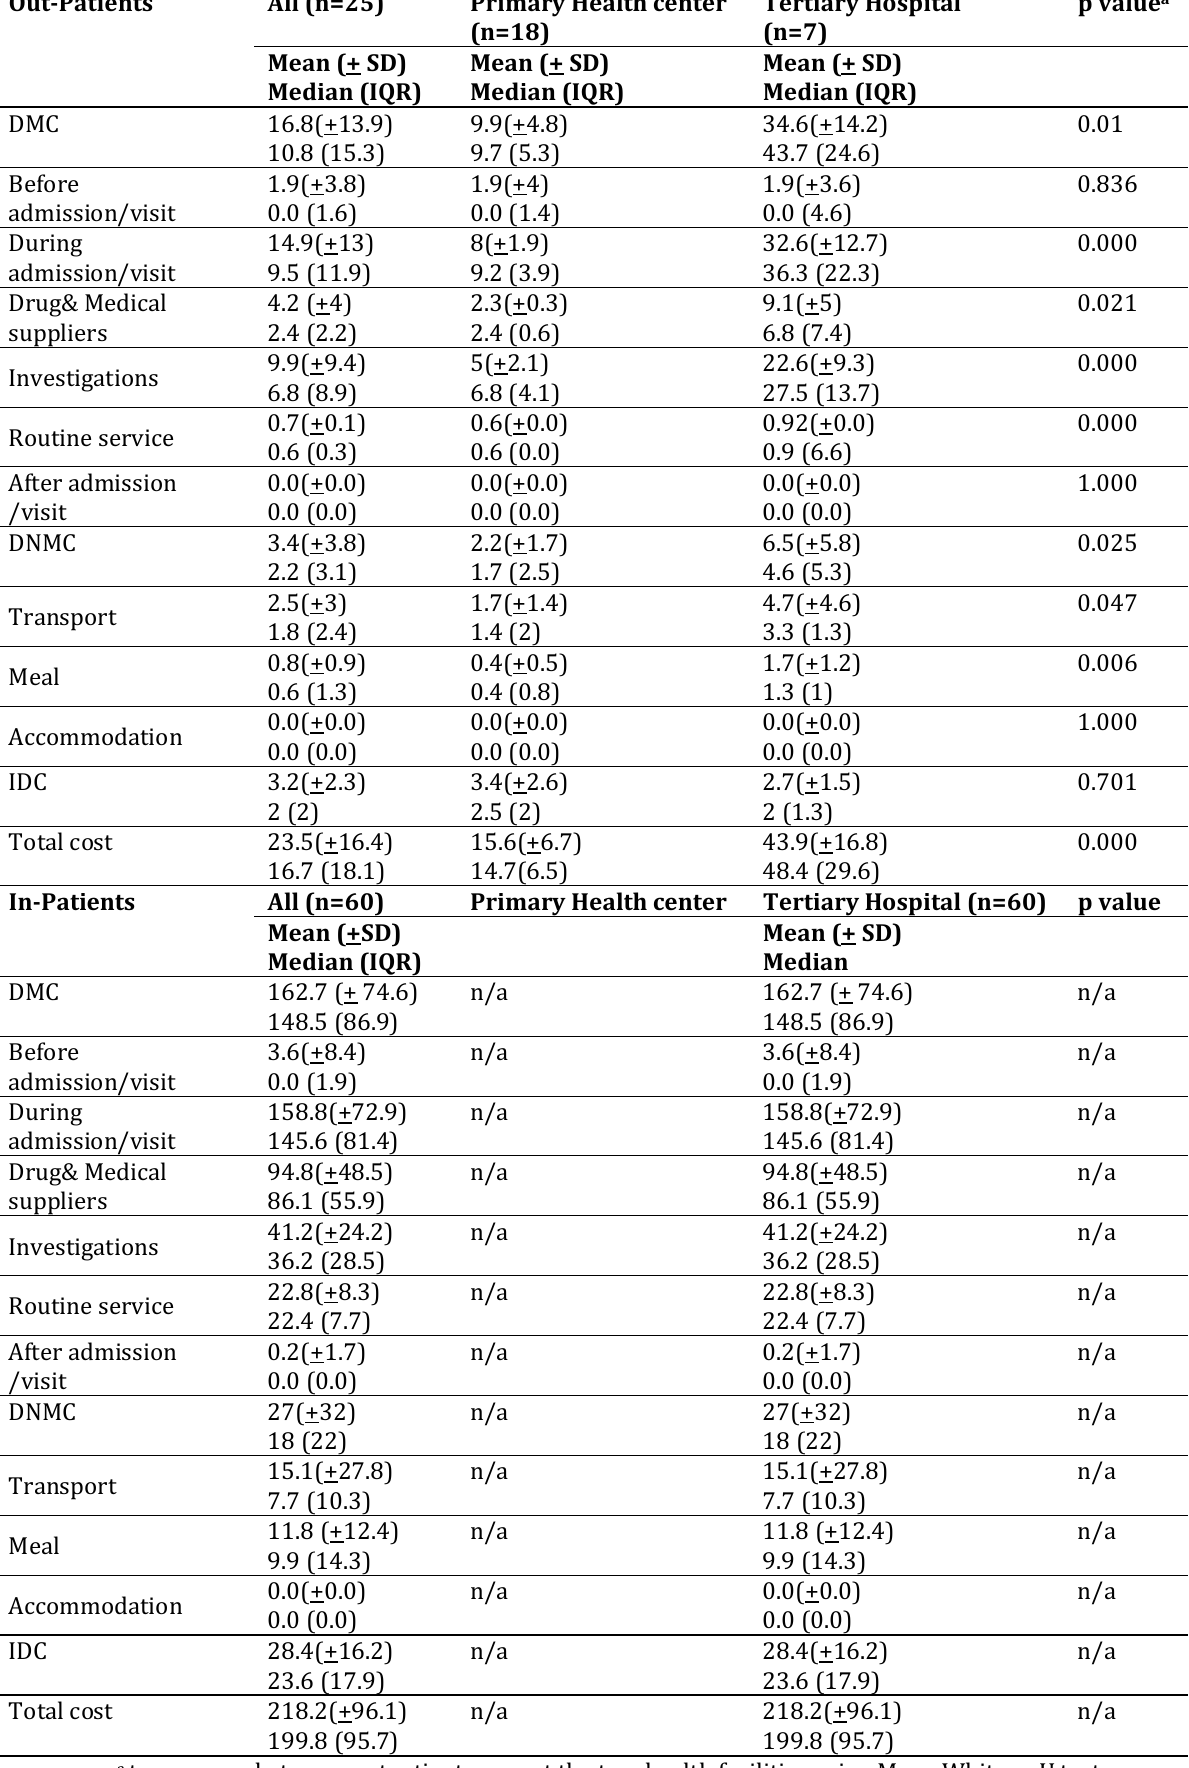
Table 3: Cost of malaria per episode by health facility and type of service (Int$, 2019 value)